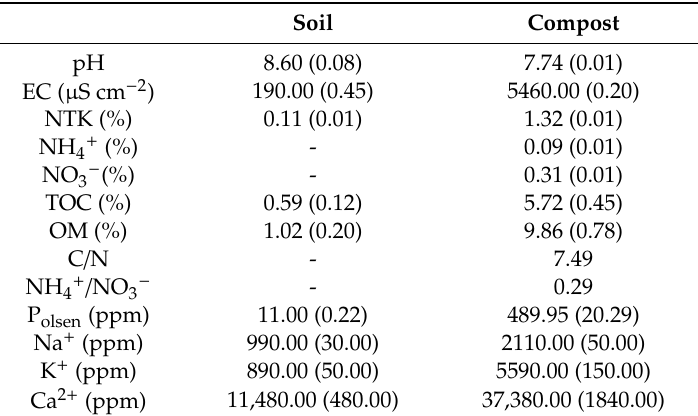
Table 1. Physicochemical parameters of the soil and